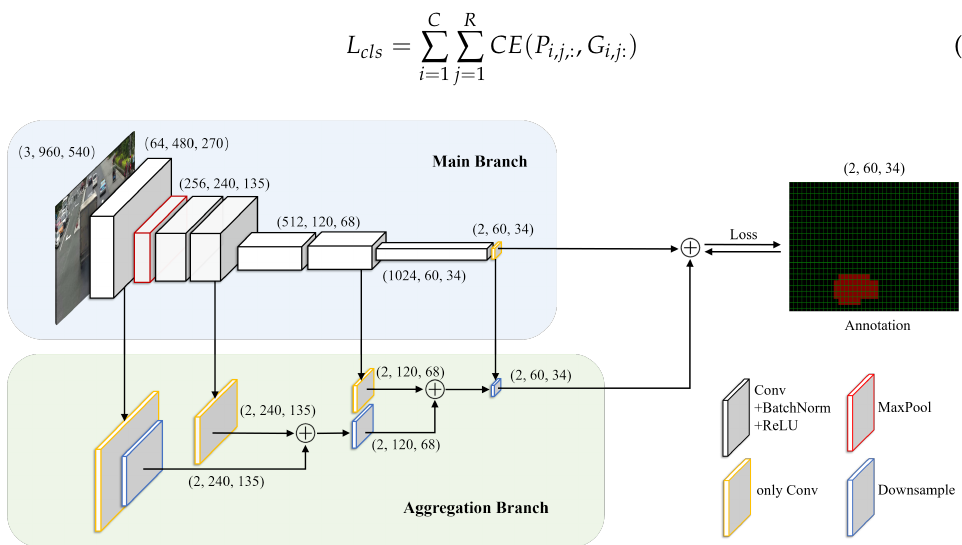
Figure 4. Overall structure of the DB-Net. The main branch is responsible for extracting features, while the aggregation branch is designed to fuse these features. The “ (cid:76) ” represent pixel-wise summation.